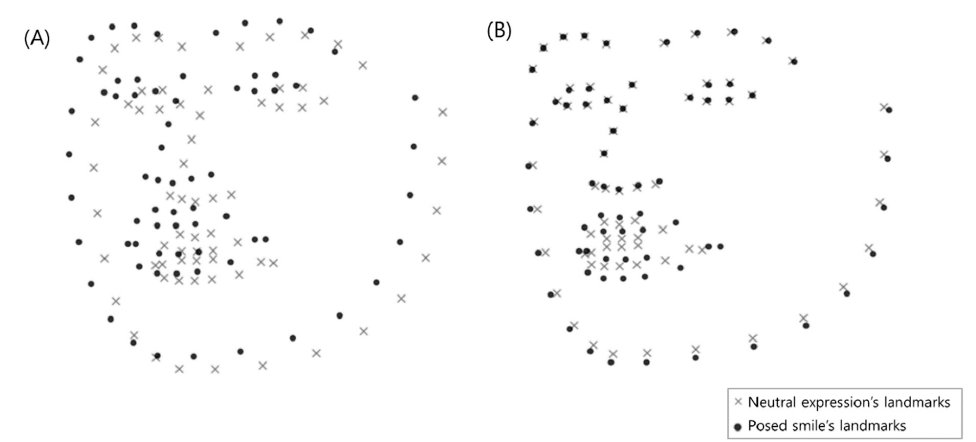
Figure 4. The example of aligning the two expression’s landmark sets: ( A ) scatter plot of two landmark data sets before aligning, ( B ) scatter plot of two landmark sets after aligning.